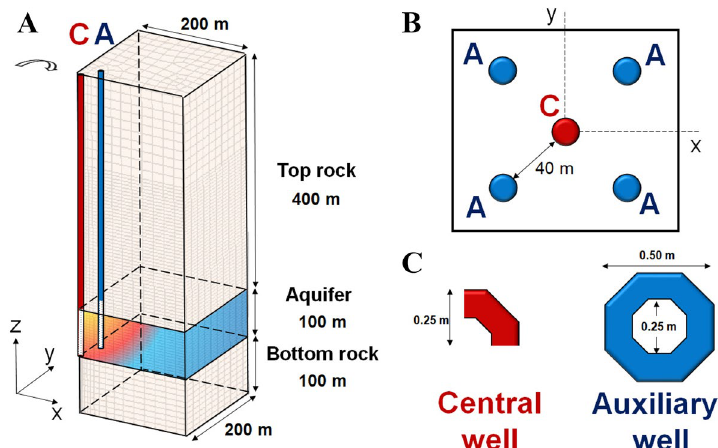
Fig. 2. 3D model ( A ), plant view of wells ( B ) and geometry of the wells used in the simulation ( C ). C represents the central well and A the auxiliary wells